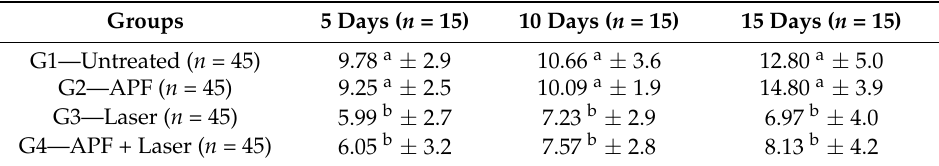
Table 2. Means ± SD ( µ m) of depth of dentin wear according to the treatments and duration of erosive/abrasive cycling. Treatments followed by distinct superscript letters differ statistically by the Tukey test ( p < 0.05).